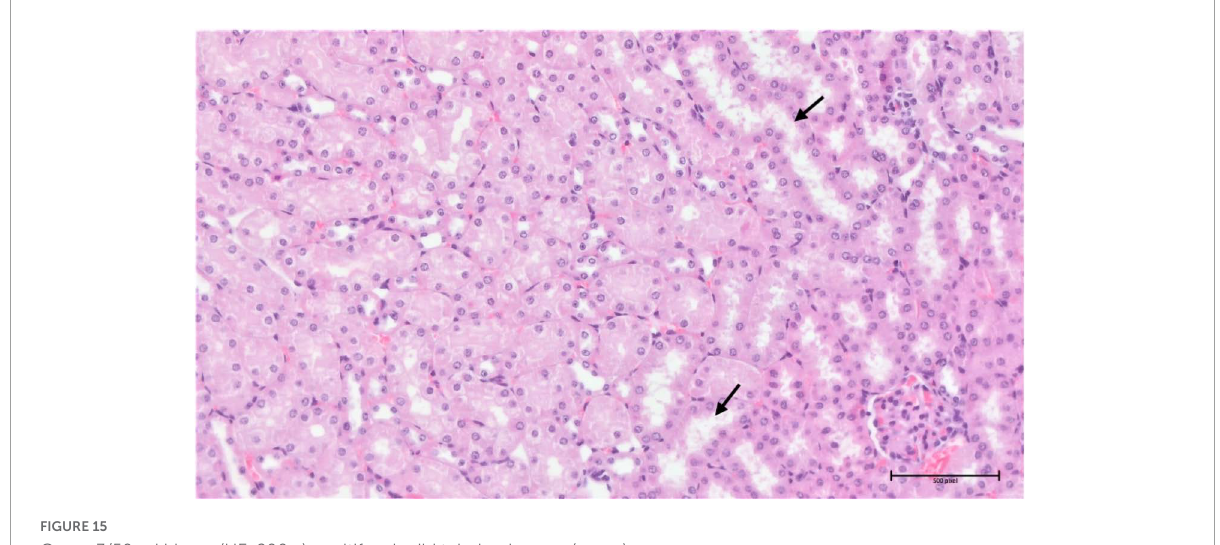
FIGURE15 Group 3/50 – kidneys (HE, 200 × ): multifocal mild tubular damage (arrow).